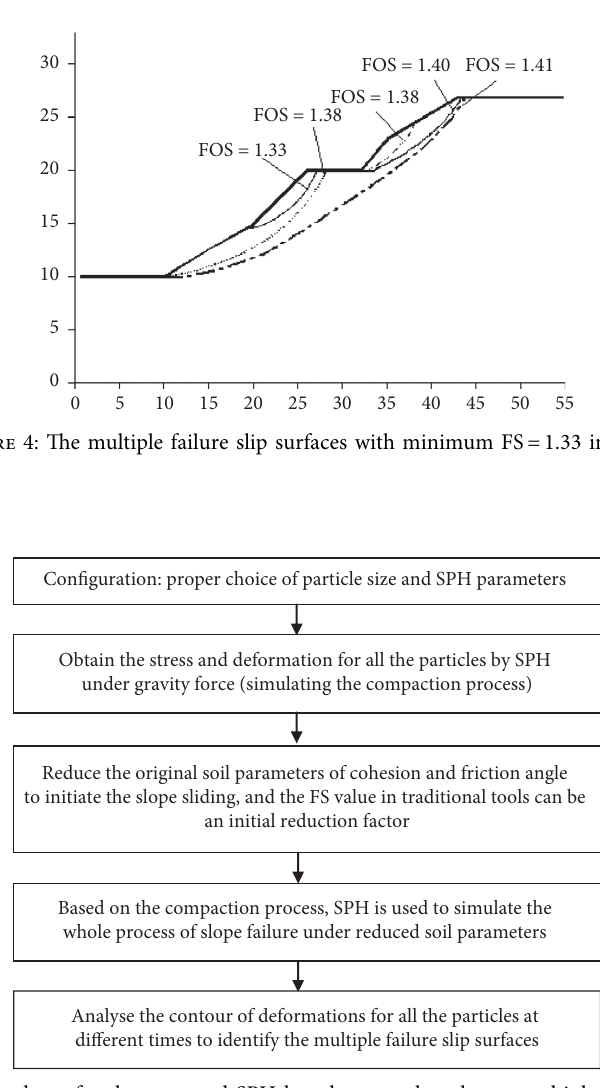
Figure 5: The procedures for the proposed SPH-based approach to locate multiple failure slip surfaces.